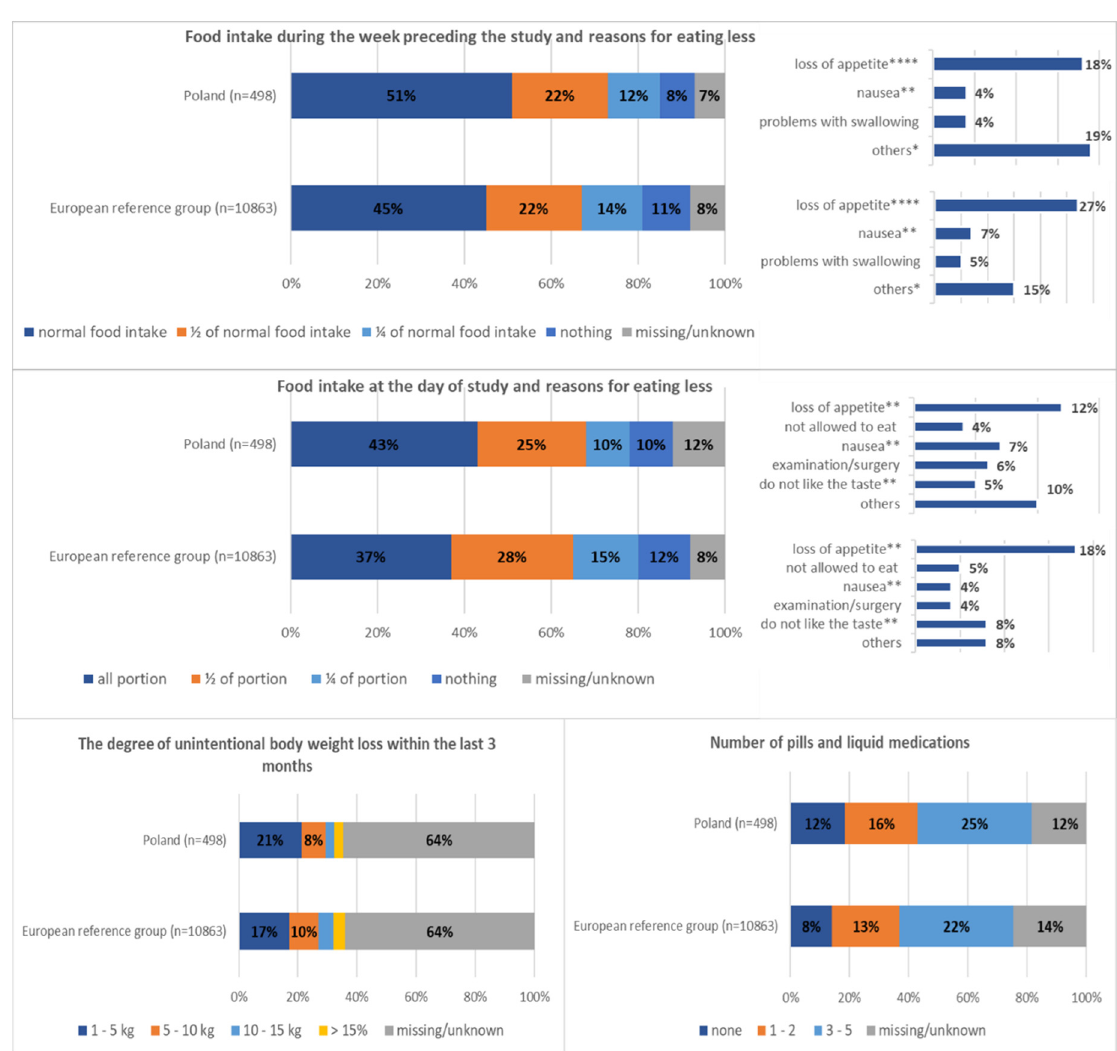
Figure 1. The most prevalent risk factors in detail. * p < 0.05, ** p < 0.01, and **** p <